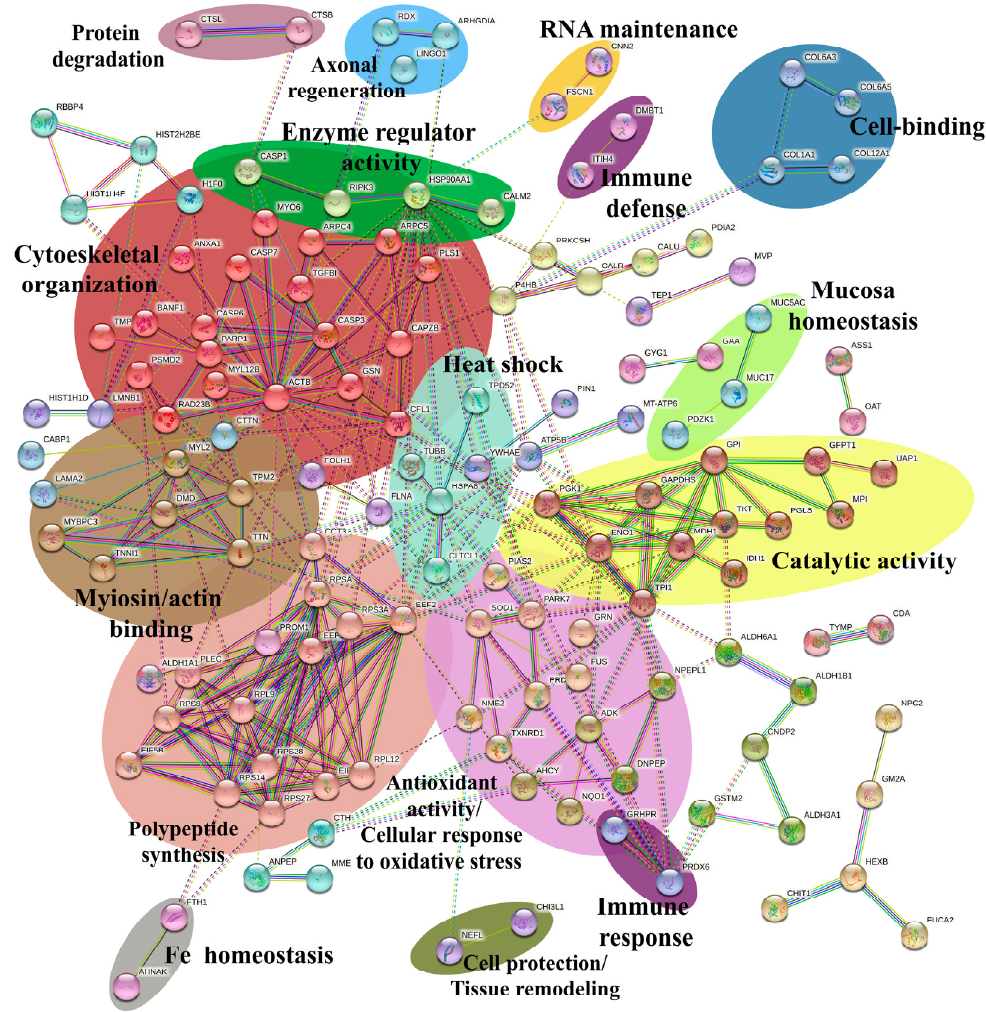
Figure 5. Protein network for the O. vulgaris skin mucus proteome with STRING (https://string-db.org, accessed on 8 June 2022) software. Nodes represent the proteins and the interactions between proteins are represented with continuous lines if referred to direct interactions (physical) or with dotted lines if referred to indirect interactions (functional).